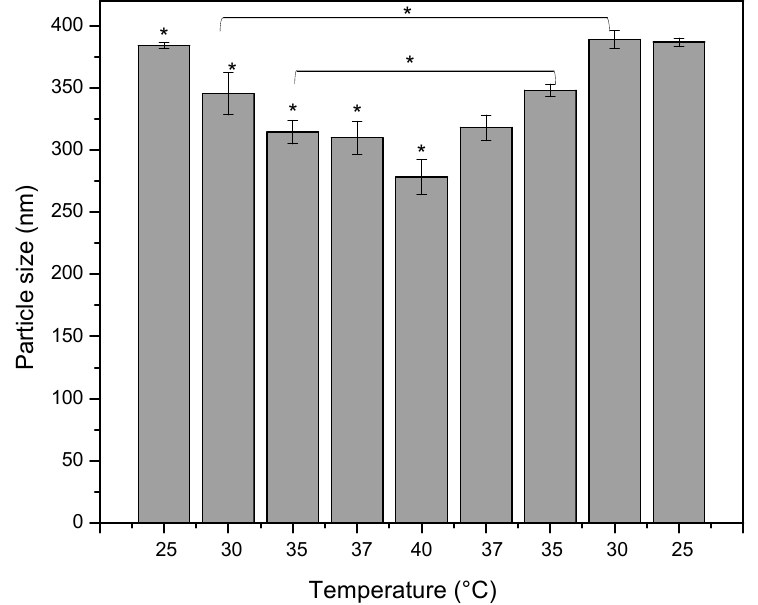
Figure 5. Effect of the temperature on the polyelectrolyte nanoparticles based on AmCh:Pec HClpH2 with concentration 1 mg/mL. Statistically significant: * p = 0.00.